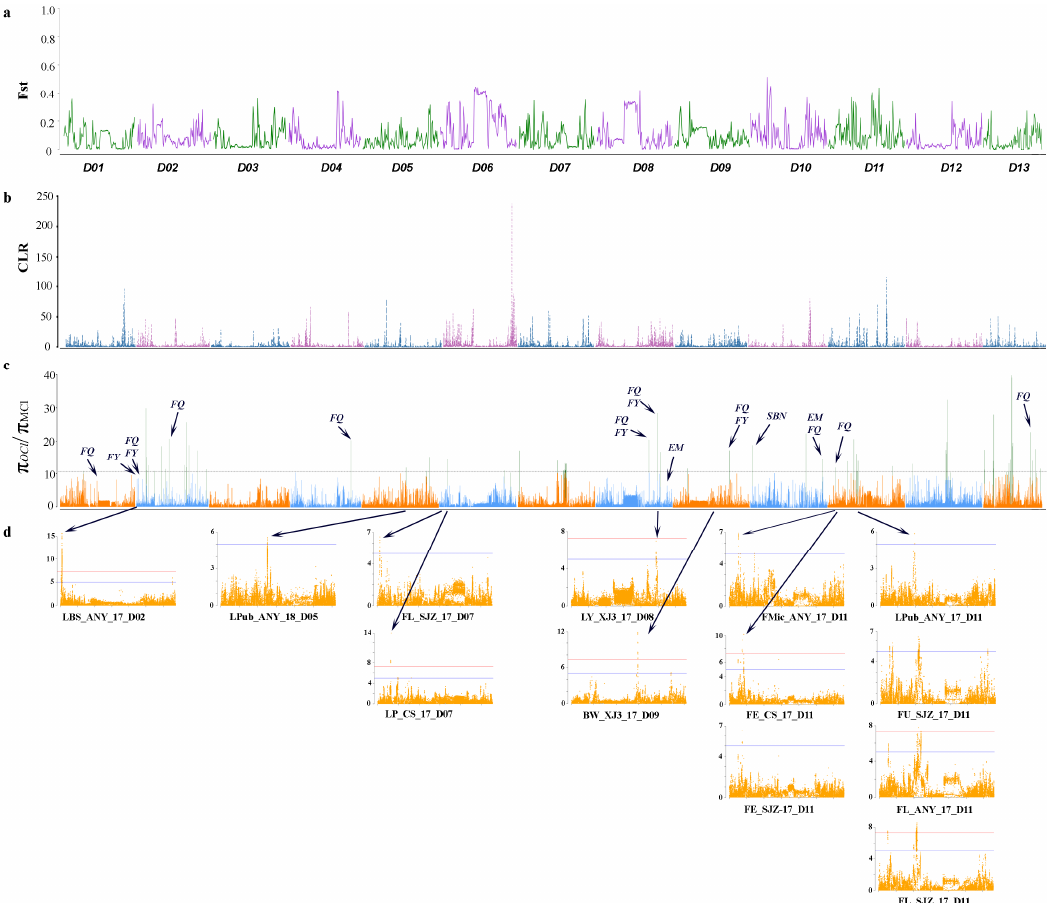
Figure 3. Genetic differentiation and identification of selection sweeps between OCl and MCl on Dt sub-genome ( a ) Population divergence ( F st) for Dt sub-genome (Chr D01–D13). A threshold of top 1% is selected as highly differentiated regions, ( b ) CLR (Composite likelihood ratio) score as an estimate of genome-wide selection sweeps, ( c ) π OCl /π MCl values (genetic diversity in the cultivated group as compare to obsolete cultivars from Southwest China) for D genome (Chr D01–D13). π ratio was calculated using whole-genome data with a 100 kb sliding window. The horizontal dotted line represents the threshold of top 1% values, whereas the threshold is represented with green columns. The annotations represent FQ = Fibre quality [28–32], FY = Fibre yield [30], SBN = Sympodial branch node and EM = Early maturity [31,33,34] which donates to previously identified hotspots/QTLs on the corresponding location, ( d ) GWAS results as Manhattan plots of multiple traits. LBS = Leaf base spot, BW = Boll weight, FMic = Fibre micronair, FE = Fibre elongation, LY = Lint yield, LP = Lint percentage, FU = Fibre length uniformity, FL = Fibre length, LPub = Leaf pubescence. ANY = Anyang, Henan Province, CS = Changsha, Hunan Province, SJZ = Shijiazhuang, Hebei Province, XJ3 = Shihezi, Xinjiang Province.